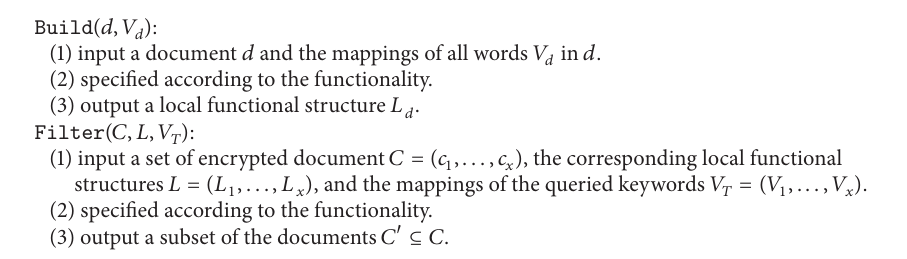
Algorithm 1: Template for functional component: FC .